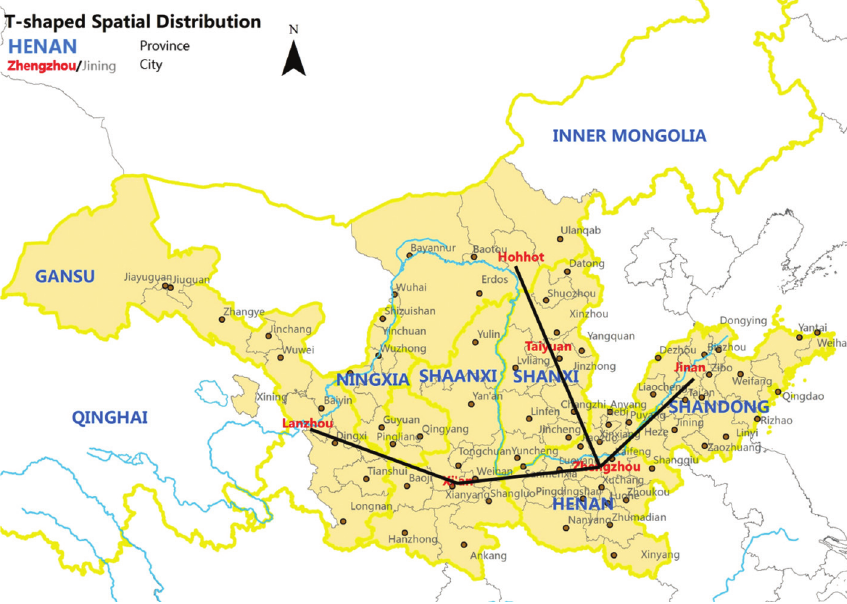
Figure 11: Spatial distribution of cities with high network